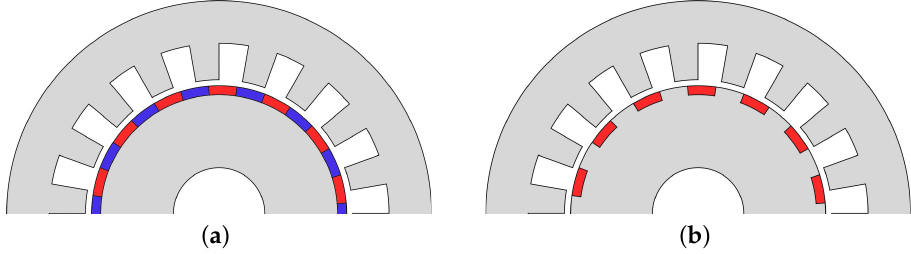
Figure 1. Comparison of both structures. ( a ) Regular VPM machine; ( b ) CP VPM machine.